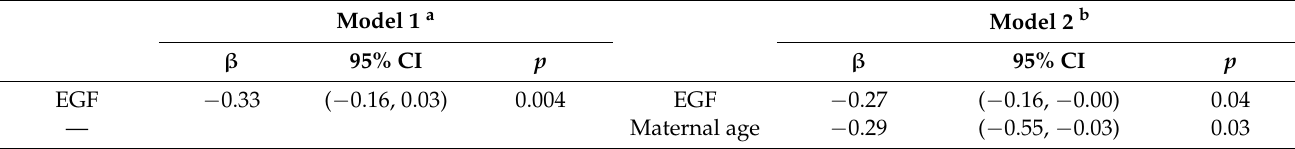
Table 4. Association between the composition of breast milk and the TcB